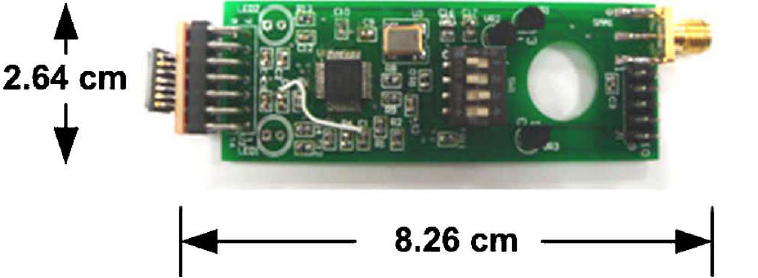
Figure 16. A photograph of the prototype of the imaging acquisition module for diagnosis of biological cells, the imager is on the left mounted perpendicular to the circuit board [162] (Reproduced with permission from Kfouri et al. , IEEE J. Sel. Top. Quantum Electron .; published by IEEE,